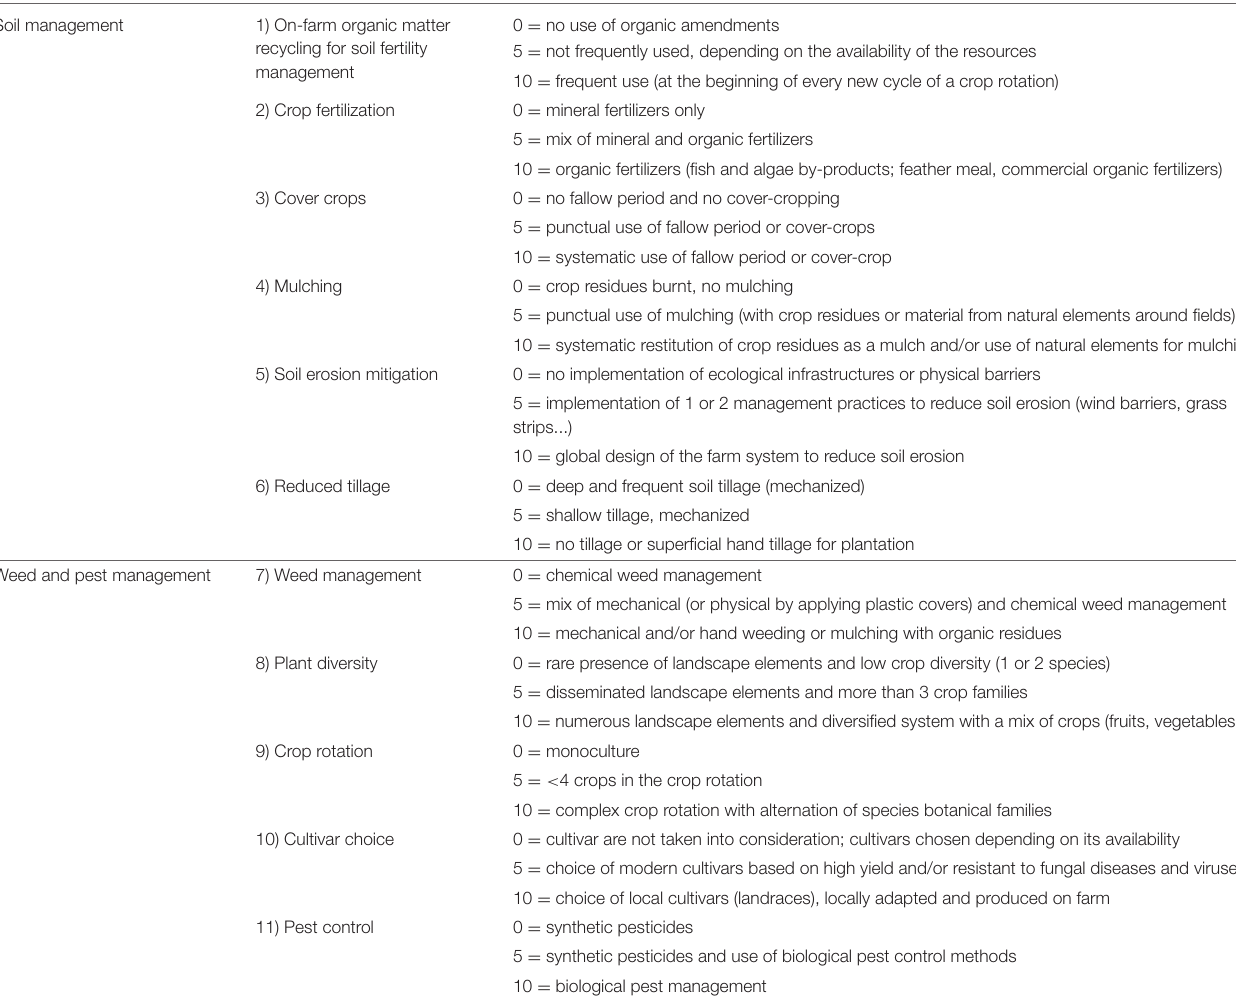
TABLE 2 | Scores (based on the MP - Table 1 ) attributed to the different management practices implemented by farmers. Soil